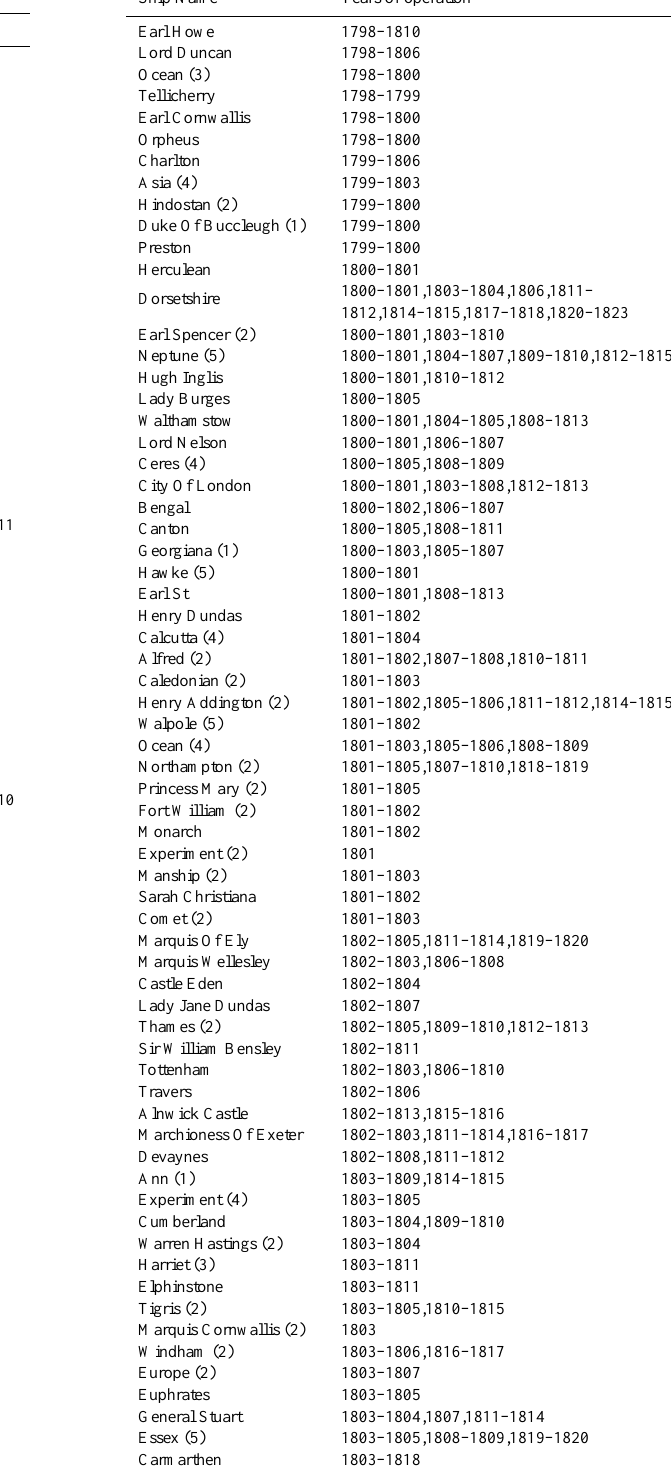
Table 2. Ships from which observations were taken (1 of 2 – starting dates 1789 to